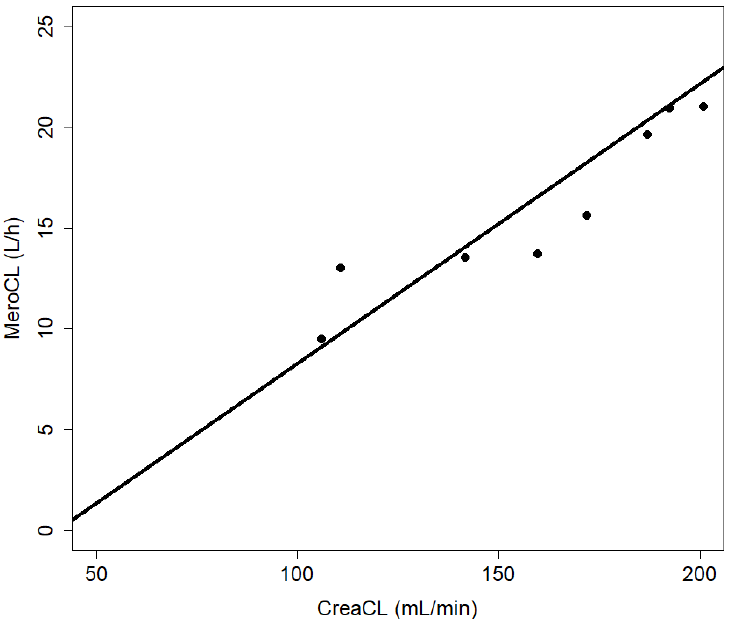
Figure 4. Meropenem and creatinine clearance. The clearance of meropenem (MeroCL) and creatinine (CreaCL) show a positive correlation with a rank correlation coefficient according to Spearman of ρ = 1.